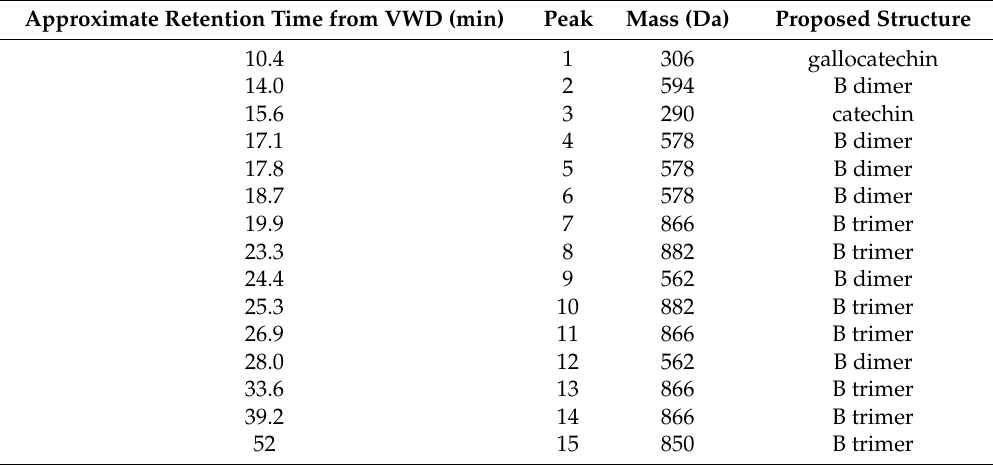
Table 1. Components identified in the ABE by